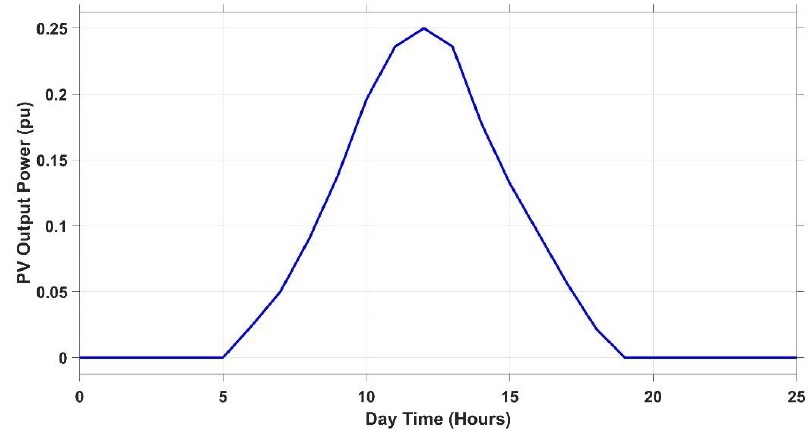
Figure 18. PV output power fluctuation.